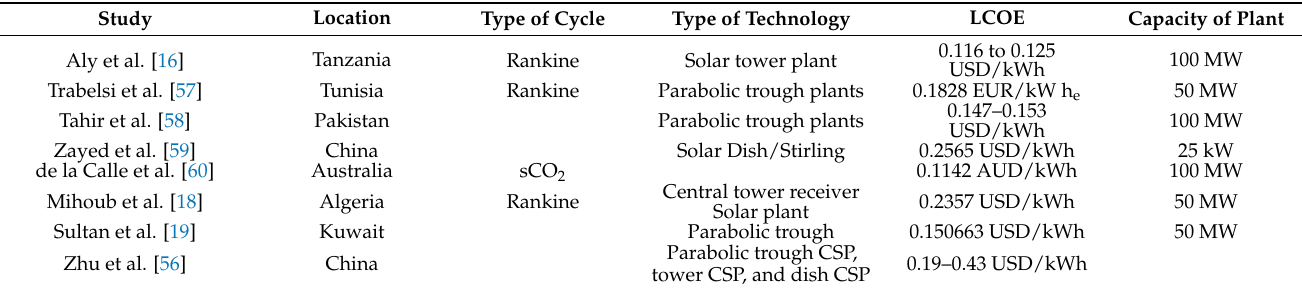
Table 4. Comparative analysis with previously published